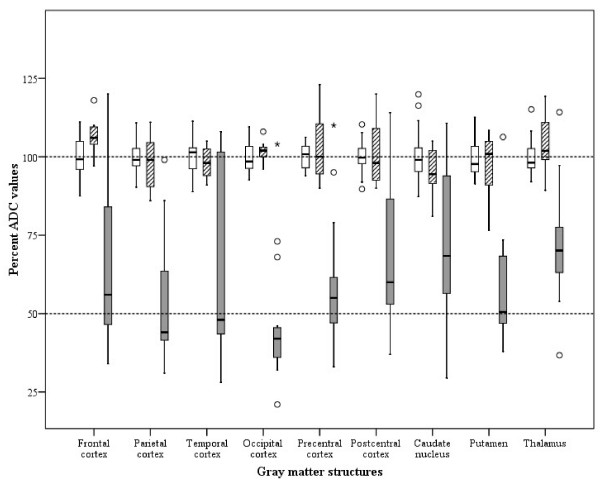
Boxplot showing the distribution of the percent apparent diffusion coefficient values for the different brain regions of the control (white bars), favourable (striped bars), and unfavourable (grey bars) groups. The percent apparent diffusion coefficient (ADC) values were calculated using the mean normal control value of each brain region.